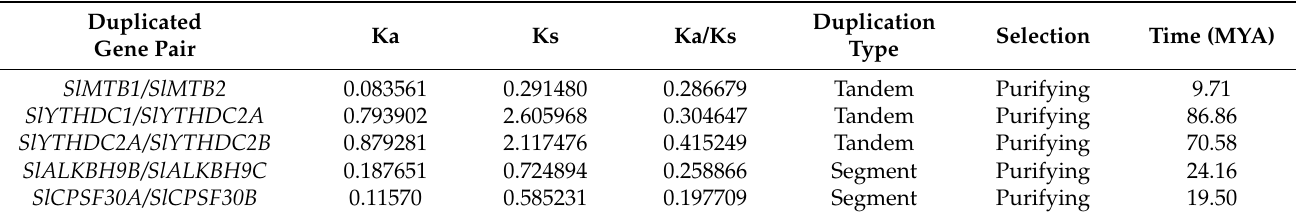
Table 2. Estimated Ka/Ks ratios of the duplicated m 6 A genes and their divergence time in